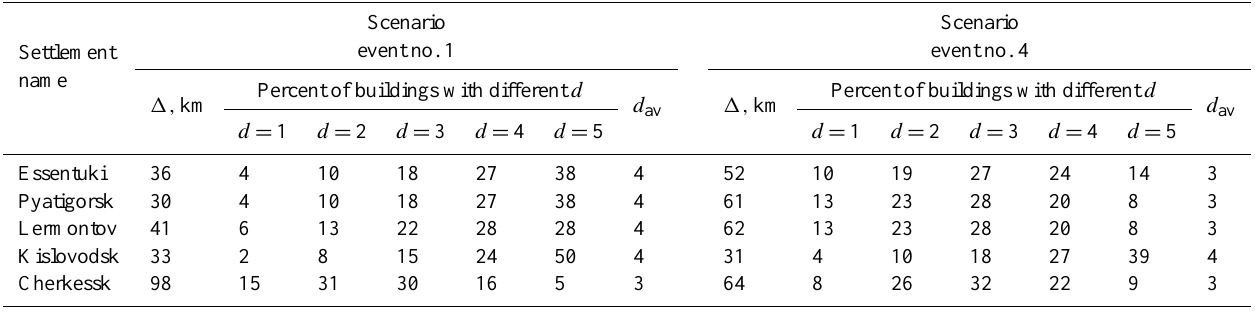
Table 5. Expected damage to building stock in settlements of the Stavropol area.